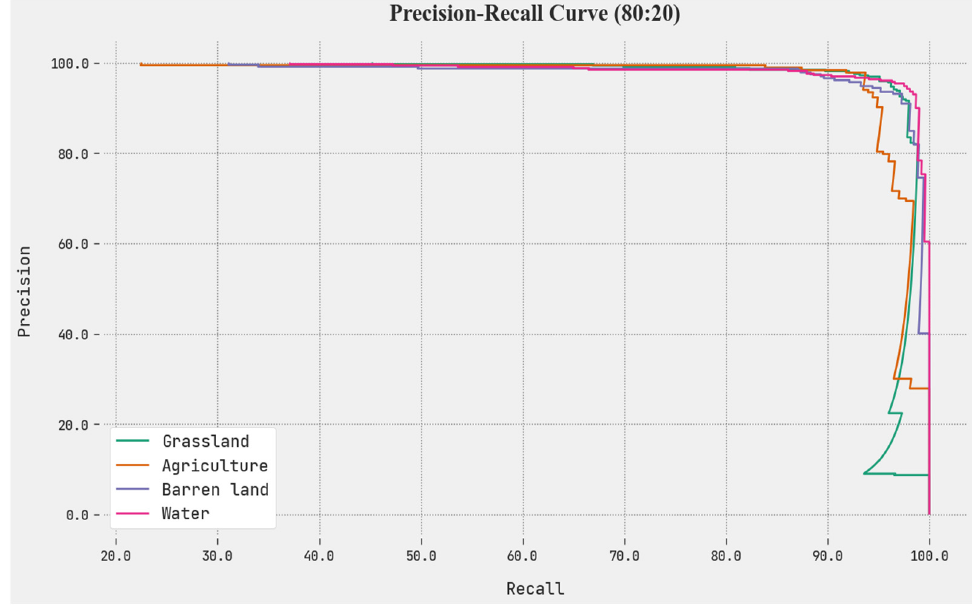
Figure 8. Precision-recall analysis of TSADL-LULCCD approach on 80:20 of TR/TS databases.